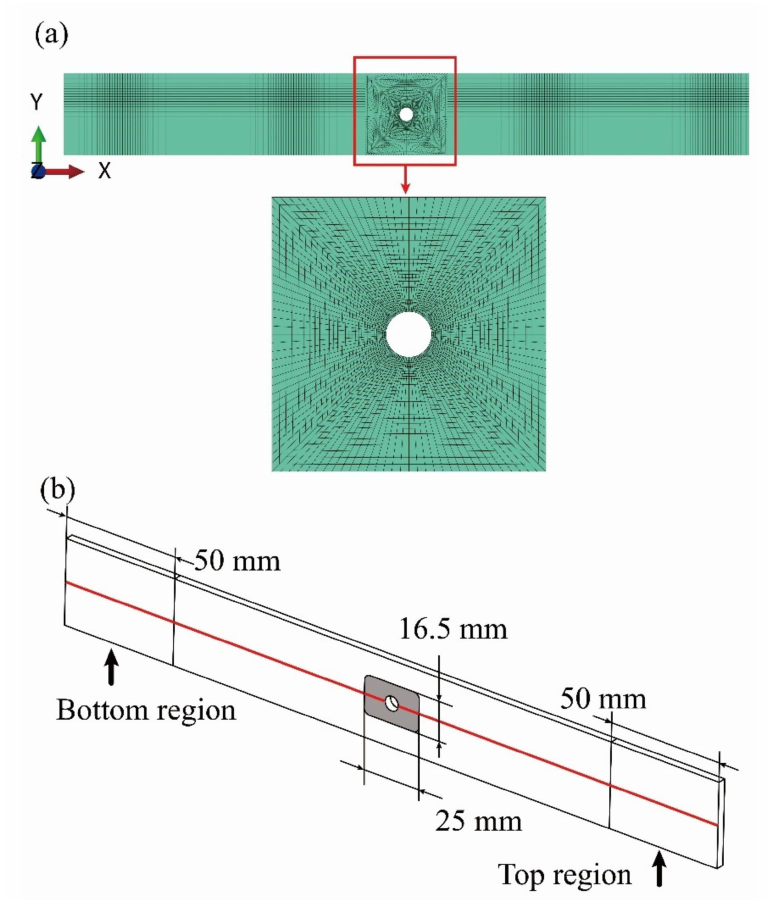
Figure 17. The macro-scale FE model of the T300/Cycom970 fabric open-hole laminates and the bound- ary conditions: ( a ) the macro-scale FE model of the open-hole laminates; ( b ) the boundary